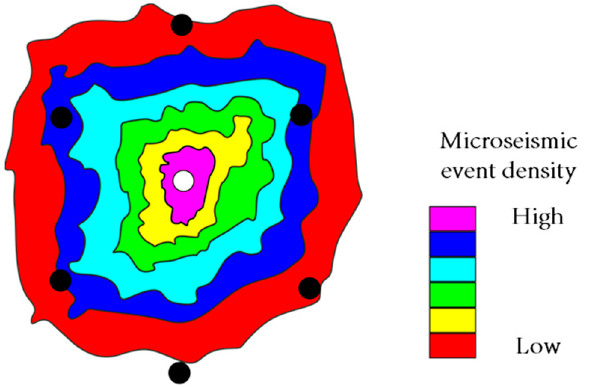
Figure 8. A schematic diagram of microseismic monitoring results in the Jilin work area in China (modified according to Ren B et al., 2016 [63]; white dots are injection wells and black dots are production wells).